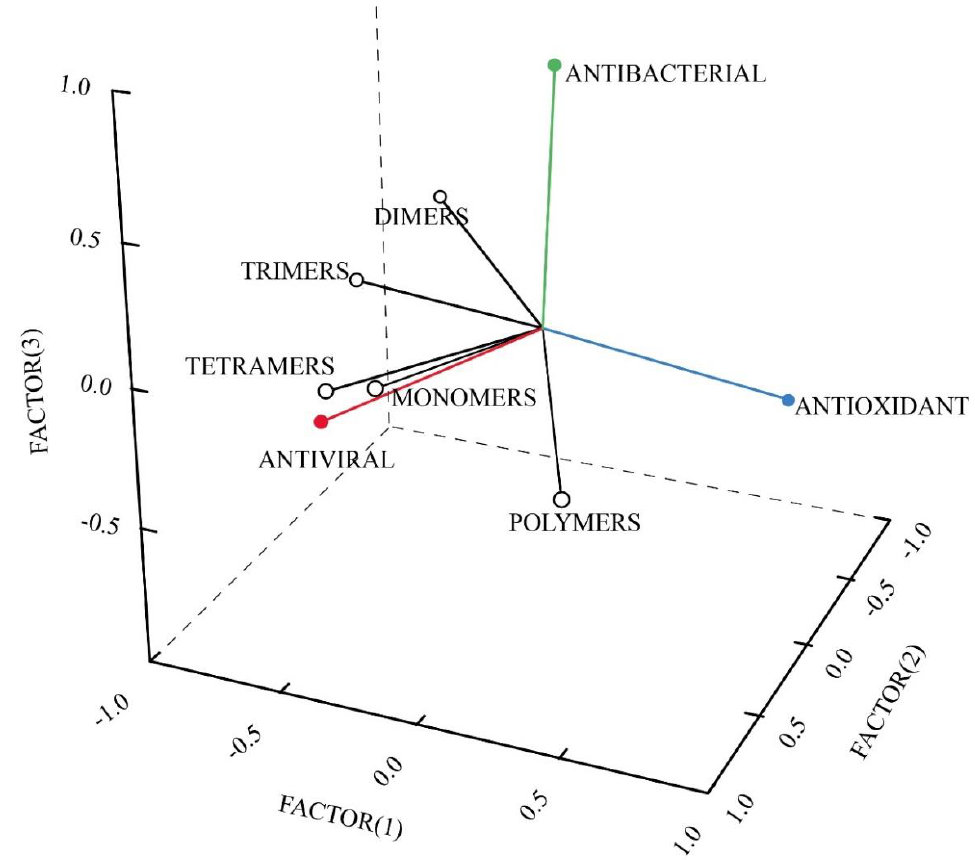
Figure 2. Factor loading plot from the Principal Component Analysis (PCA) performed on data summarized in Table 1 and Table 2 by considering the different degrees of PAC-A polymerization and the three main biological effects. Antiviral activity is associated mainly with A-type PAC monomers, dimers, trimers and tetramers. Antioxidant activity is correlated with A-type PAC polymers with a degree of polymerization > 5. Antibacterial activity is correlated primarily to PAC-A dimers and trimers. Varimax rotation; total variance explained by the three factors: 26% factor (1), 24% factor (2) and 17% factor (3).